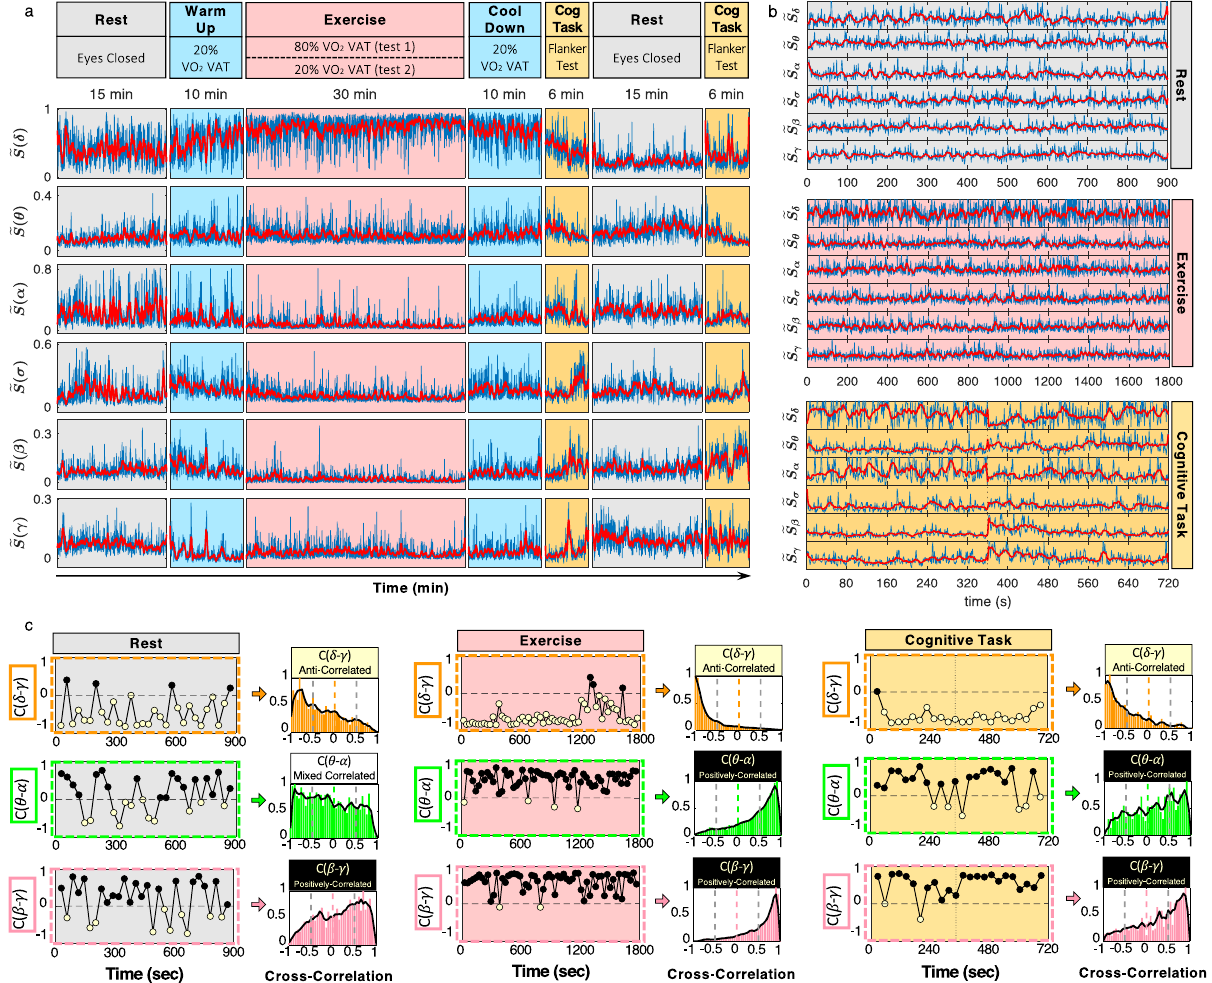
Fig. 1 Synchronous modulation in spectral components of complex brain dynamics underlie distinct coupling pro fi les of brain-rhythm interactions. a (Top panel) Schematic diagram of the time course of experimental protocol consisting of consecutive sessions of distinct physiological states (rest, warm- up, exercise, cool-down, cognitive task) with corresponding experimental conditions and set-ups for physiological data recording. The protocol was repeated twice, for high and low physical effort during exercise, with respectively 80 and 20% ventilatory anaerobic threshold (VAT) (see Methods). (Bottom panels) Time series of the relative spectral power, e S ð Δ f i Þ of physiologically relevant brain rhythms (frequency bands, Δ f i = { δ , θ , α , σ , β , γ }) derived from C3 EEG channel of a representative subject at 80% effort level (blue lines) and moving average (window 14s; step 1 s; red lines) illustrating synchronous modulation in the micro-architecture of cortical rhythms within each physiological state (Methods). b Time series of relative spectral power e S ð Δ f i Þ from a representative subject for segments of rest, exercise (at 20% effort level), and cognitive tasks (blue lines; vertical dotted lines indicate the concatenation of two segments). Moving averages (red lines) show coordination among cortical rhythms during all three physiological states with synchronous modulation in e S ð Δ f i Þ at small time scales (s) indicating dynamic interactions between dominant and non-dominant brain rhythms. c Cross-correlation C between e S ð Δ f i Þ moving averages for selected pairs of brain rhythms in non-overlapping 30s windows (left panels) and corresponding normalized histograms of cross-correlation values (right panels, population average) during rest, exercise (at 80% effort level), and cognitive task from the same representative subject. Note predominantly negative C values for δ - γ coupling and predominantly positive C values for β - γ coupling during all three physiological states (left panels in c ). Correlation distribution pro fi les (right panels in c ) reveal three classes of brain-rhythm coupling: stable anti-correlations (predominantly negative C values for δ - γ coupling); stable positive correlations (predominantly positive C values for β - γ coupling); and mixed correlations where the distribution pro fi le changes from homogeneous during rest to positive cross-correlations during exercise and cognitive task ( θ - α